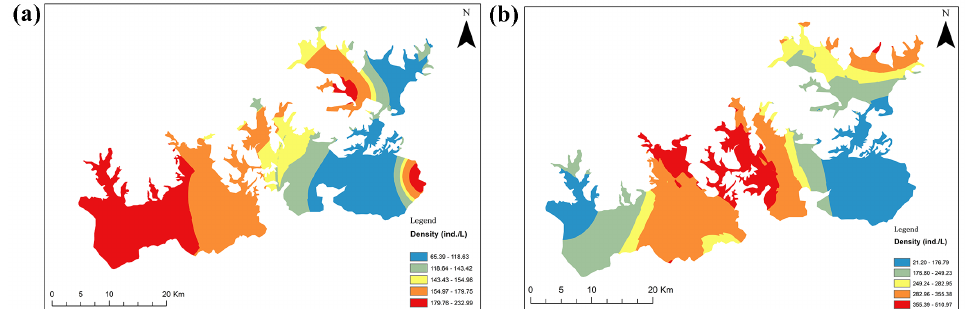
Figure 4. Spatial distribution of zooplankton density in the period of extreme water level fluctuation ( a ) and in the period of regular water level fluctuation ( b ).